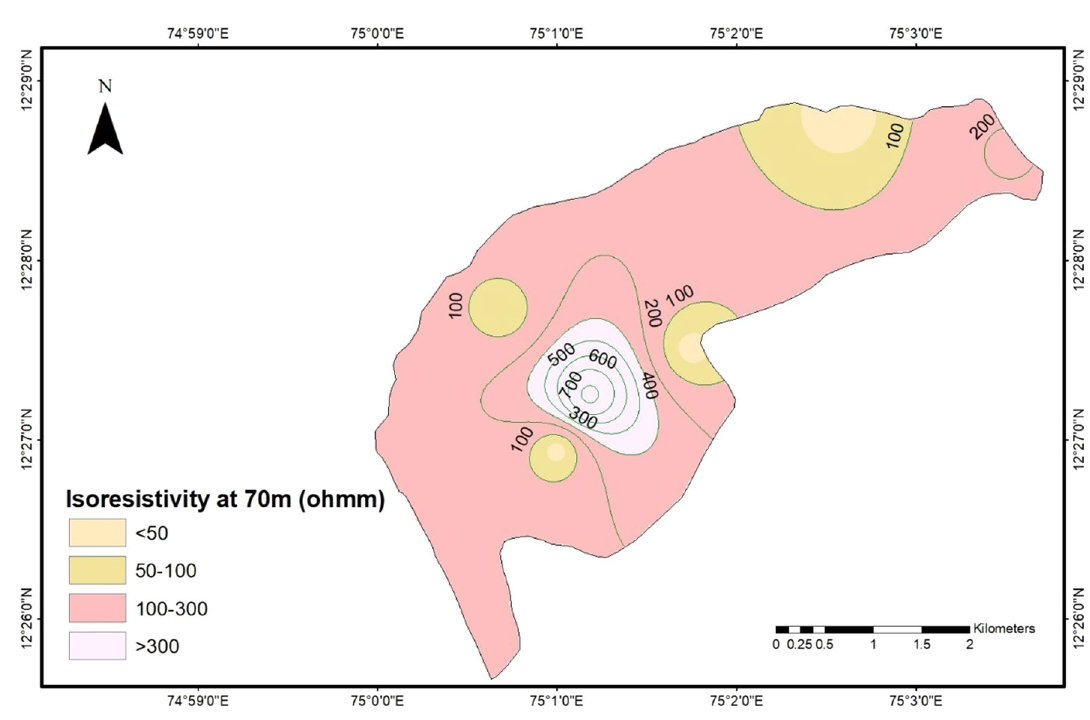
Fig. 12 Isoresistivity at 70 m depth of Kalanad river